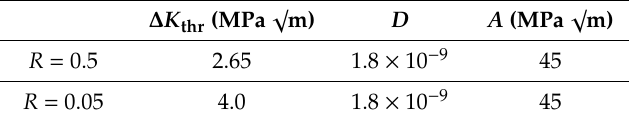
Figure 8. Hartman–Schijve representation of crack growth in AA2024-T3. Table 1. The values of ∆ K thr used in Figure 8.